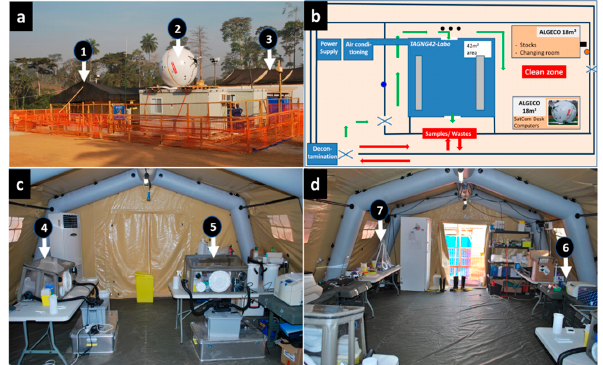
Figure 1. Organisation of the B-LiFE base of operation during the Ebola mission in Guinea. There were several modules consisting of ( a ) fully equipped inflatable laboratory tent ( 1 ), two containers for laboratory supplies and the command centre with a satellite internet network ( 2 ), and the Ebola treatment centre located inside the red zone and apart from the B-LiFE ( 3 ). ( b ) The laboratory tent, supported by a cement platform, is surrounded by two fences, one of which protects the overall perimeter of the laboratory and its auxiliary structures (including the power supply and air conditioning), and the other encloses the sensitive operational area (i.e., the laboratory tent and two Algeco containers). The tent and the two containers delineate the clean zone. The red arrows indicate the path followed by ECT personnel when bringing in samples, starting at a decontamination station (foot and hand washing) and ending at a “Samples/Wastes” window in the inner fence, opposite the front of the laboratory. Samples are passed to the laboratory staff through this window. The laboratory staff follows the same path to dispose of the waste (the laboratory wastes are systematically stored next to the window). The entrance and exit to the laboratory are located at the front of the tent. The green arrows show the path that the B-LiFE members must take to enter the tent or reach the clean zone. The blue and brown circles within the inner fence’s right and left borders indicate the location of the poles that support the outdoor Wi-Fi access points (router). The three black circles on the front of the tent represent water taps (chlorinated water). The uninterrupted power supply (UPS) is represented by the black rectangle to the right of the Algeco container in the top left corner. ( c ) Inside the laboratory tent, different gloveboxes were used for virus inactivation ( 4 ), biochemical testing ( c ) ( 5 )—note that the large plexiglass glovebox was not in place at the time of the photo. ( d ) The extraction ( 6 ) and PCR ( 7 ) workstations were located at the entrance of the